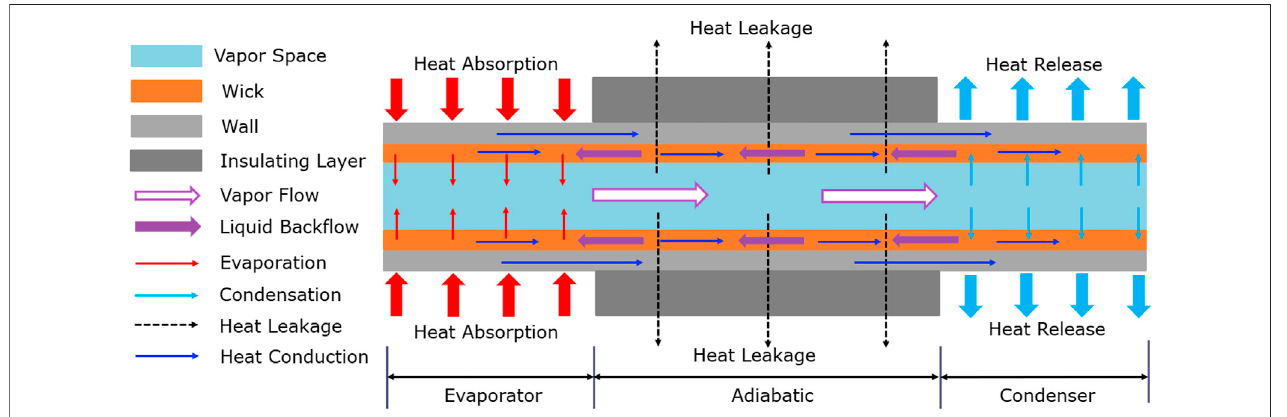
FIGURE 1 | Basic diagram of the heat pipe structure and main heat transfer